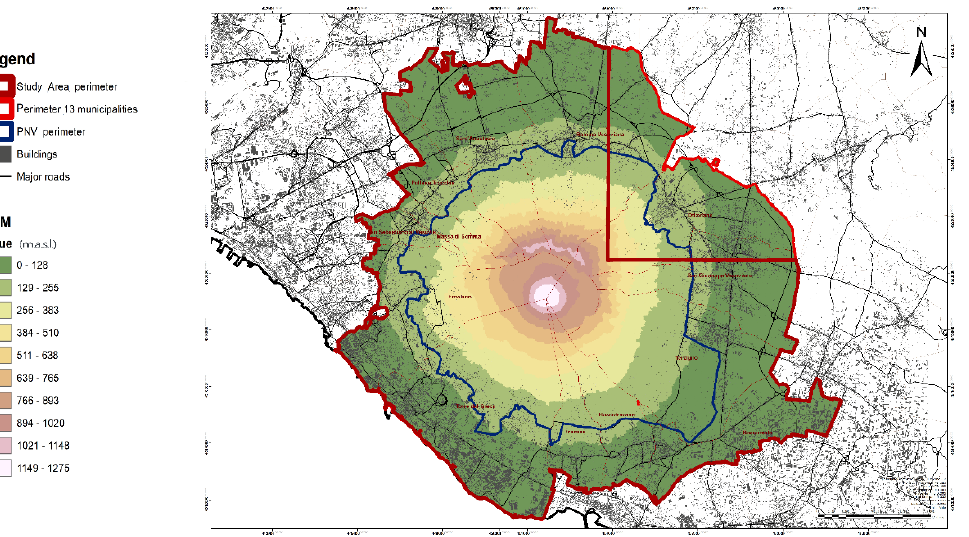
Figure 2. The study area based on a 2005 Regional Topographic Map.